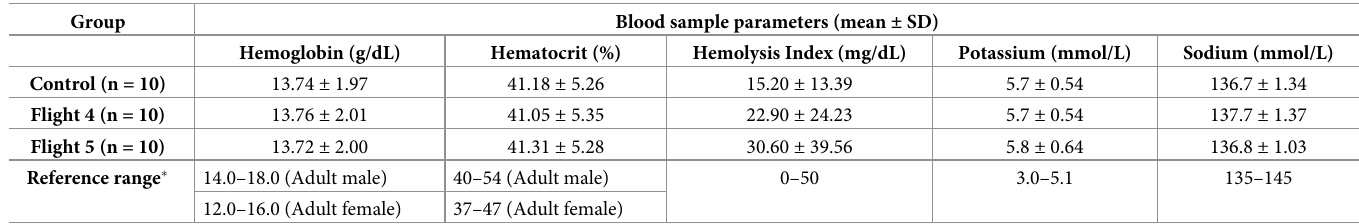
Table 2. Mean and standard deviation (SD) of hematological and biochemical blood parameters from Phase 2 (F4 and F5) with the reference range.